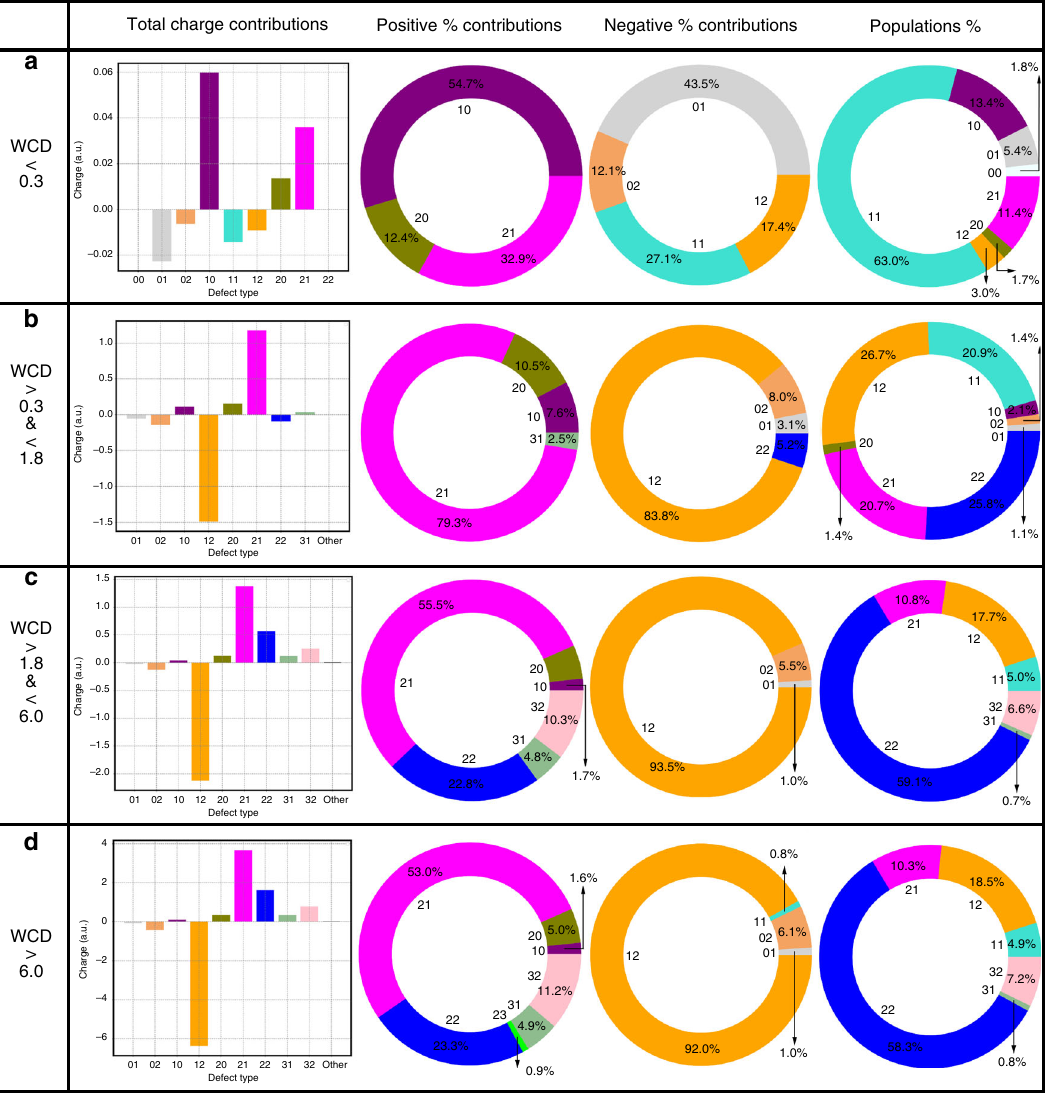
Fig. 3 Water/air layer-by-layer charge and population contributions. Analysis of the water – air interface layer-by-layer (as de fi ned in the main text) in terms of the average total charge contribution, percentage contribution to the positive charge, percentage contribution to the negative charge and percentage contribution to the overall population for each water coordination con fi guration. a reports the different contributions for the fi rst layer, b for the second layer, c for the third layer and d for the fourth